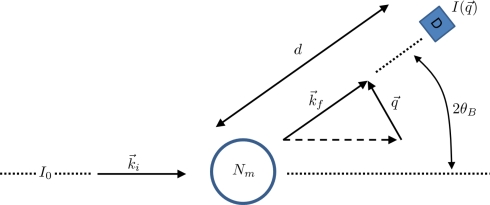
General set up of a scattering experiment according to [206]. Details are described in the main text.